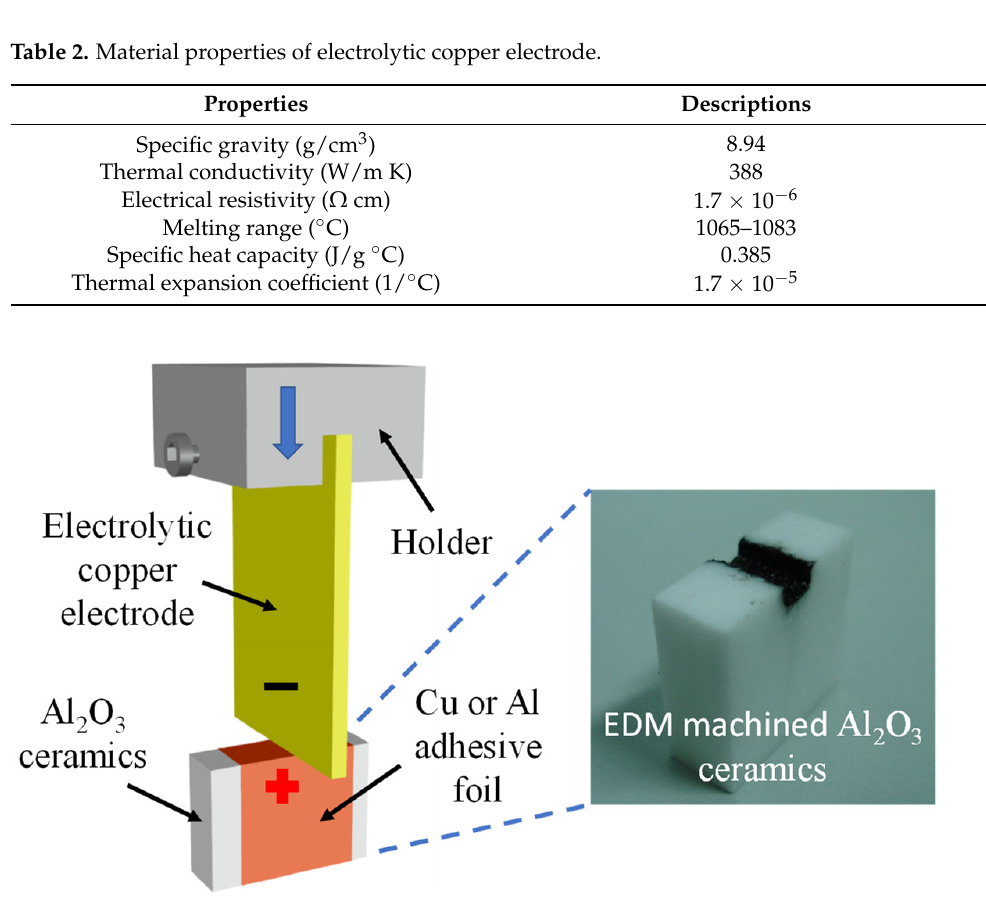
Figure 2. Schematic diagram of EDM electrode and workpiece setting. Table 3. Material properties of adhesive Cu and Al foils.